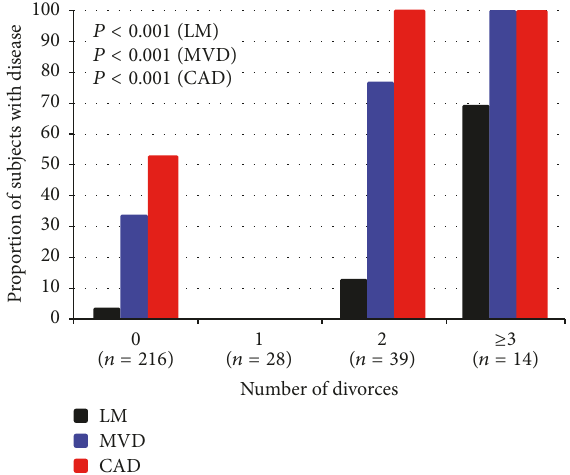
Figure 1: Relationship between number of divorces and severe CAD, MVD, and LMD in